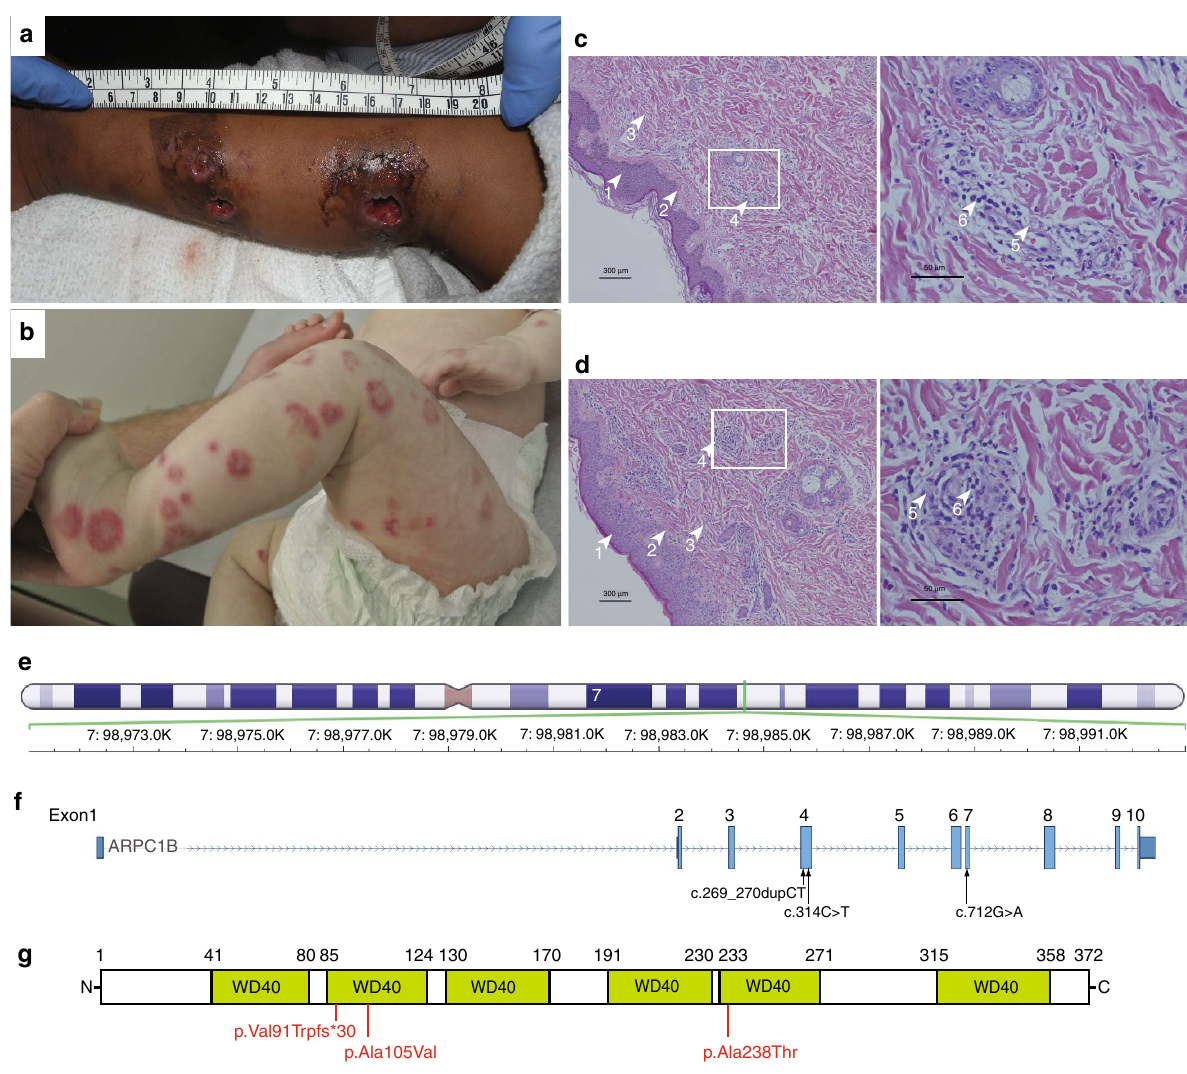
Figure 1 | Vasculitis pathology and description of ARPC1B variants in patients. Patient 1 ( a , c ) and Patient 2 ( b , d ) developed skin lesions associated with small vessel vasculitis. Patient 1 ( a ) had a complicated ulcerating lesion after a skin biopsy preceded by the more typical skin lesions seen in Patient 2 ( b ). Images a , b are not included in the Creative Commons license for the article. Small vessel vasculitis was confirmed by skin biopsies ( c , d ); arrowheads indicate: (1) epidermis, (2) dermal–epidermal junctions, (3) dermis. At low magnification ( c , d , left panels) areas of leukocytoclastic vasculitis (4) were evident, which at higher magnification ( c , d , right panels) showed vessel wall destruction (5) and neutrophil infiltration (6). ( e ) ARPC1B is located on Chromosome 7 (position numbering relative to GRCh37), immediately preceded by ARPC1A . ( f ) Nucleotide positions of identified mutations (black arrows) relative to ARPC1B